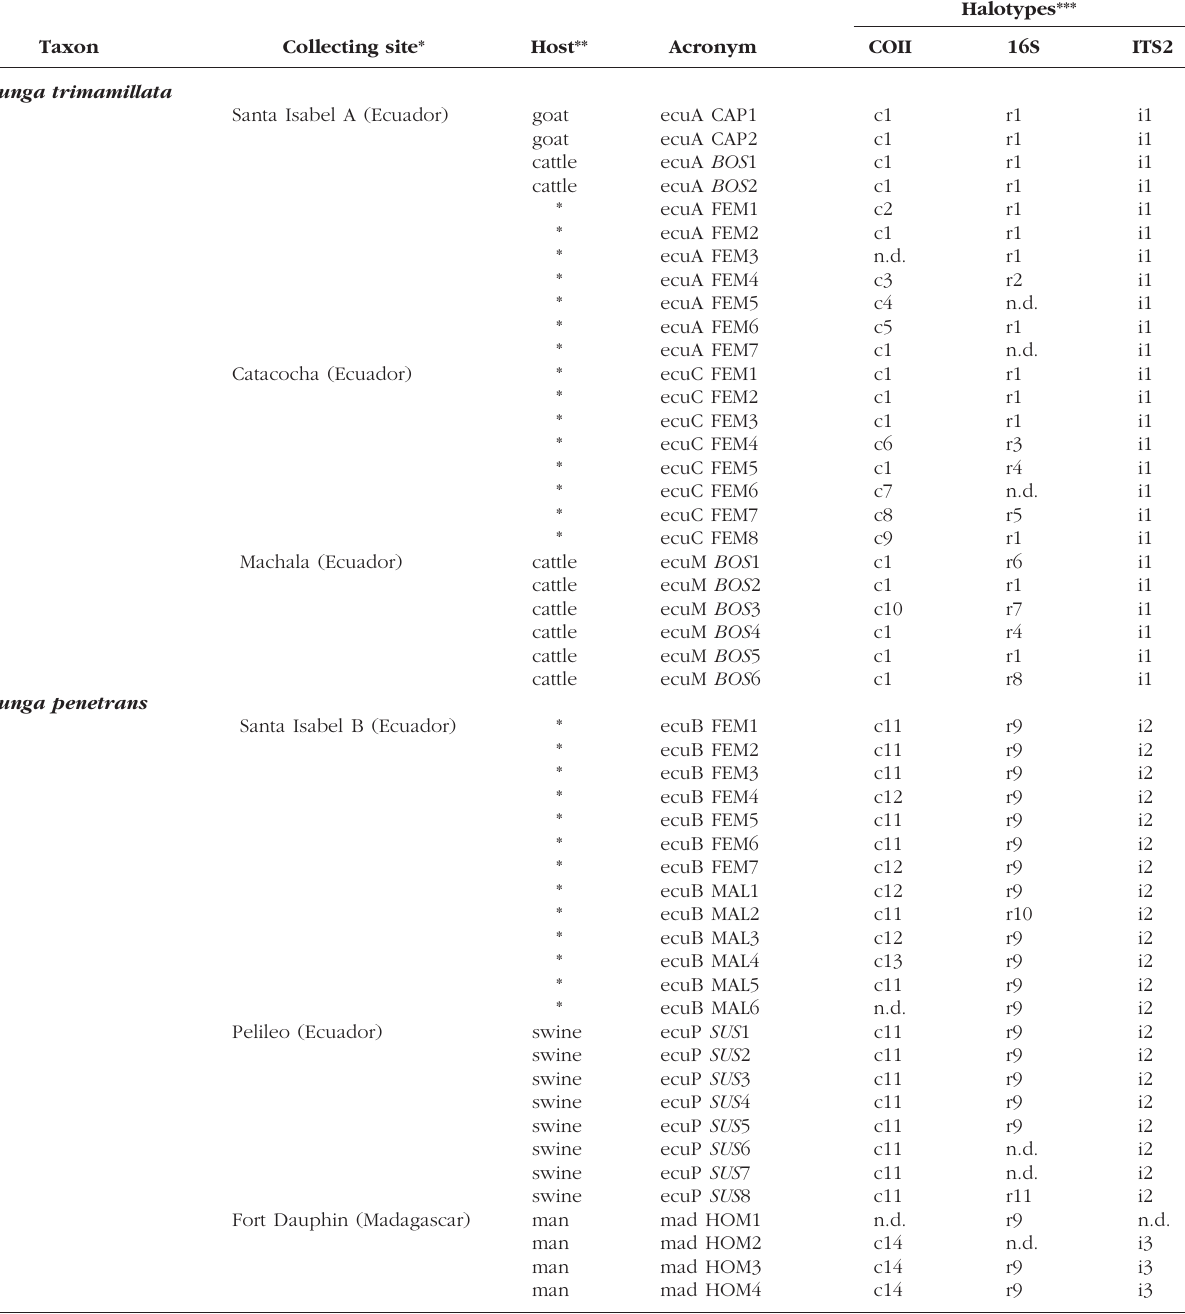
Table I. – List of analyzed specimens: collecting sites, hosts, acronyms and related haplotypes are